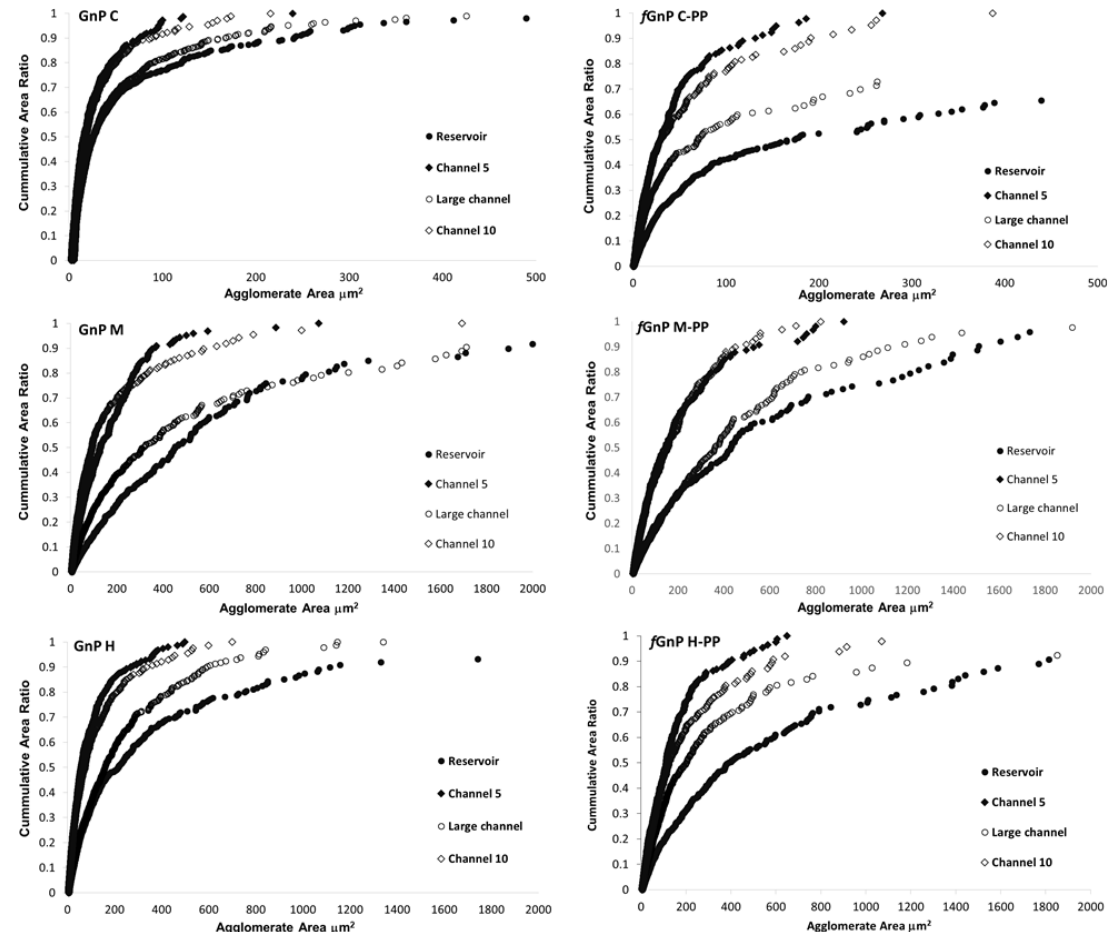
Figure 5. Representation of the cumulative agglomerate area distribution measured for the PP/GnP and PP/ f GnP-PP composites collected along the mixer.